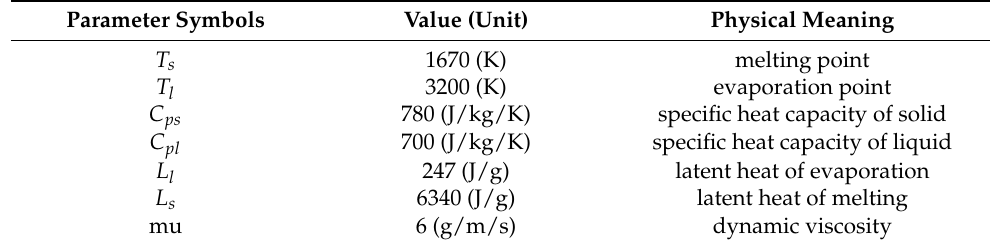
Table 1. Thermodynamic parameters of TC4.